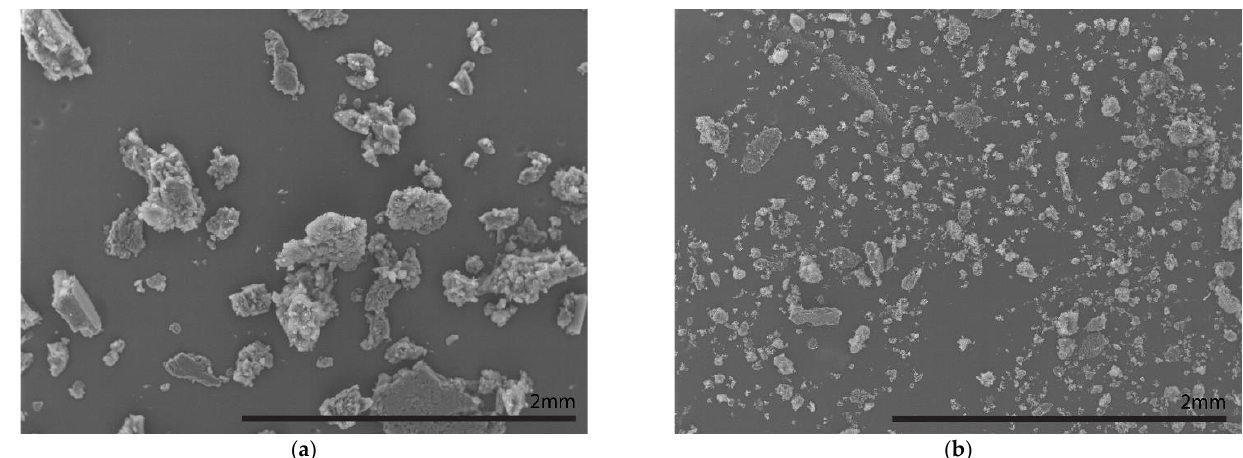
Figure 5. Soot’s SEM pictures for the H 2 :CH 4 ratio of 4:1 ( a ) and 0:1 ( b ).